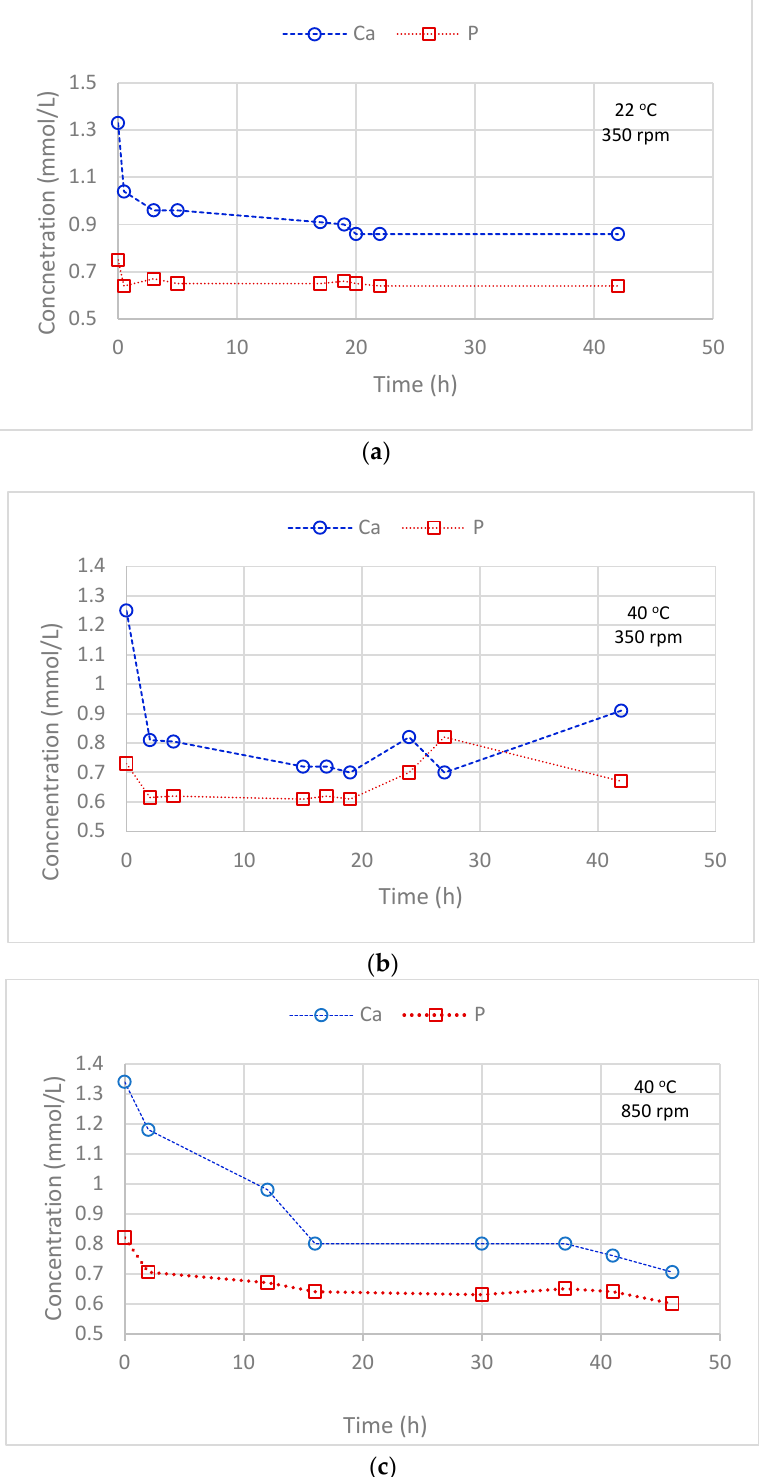
Figure 4. P and Ca concentrations as a function of time during three nucleation experiments at ( a ) 22 °C and 350 rpm, ( b ) 40 °C and 350 rpm and ( c ) 40 °C and 850 rpm. Low agitation speed and higher temperature (higher solubility, therefore lower su- persaturation) stimulated the heterogeneous precipitation of calcium phosphate on the surface of scorodite and these conditions were adopted for the rest of the work. It must be